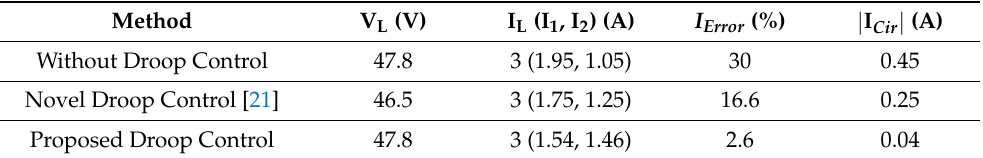
Table 8. Comparison of simulation results of different methods considering variation in source voltage and load with different cable resistances.